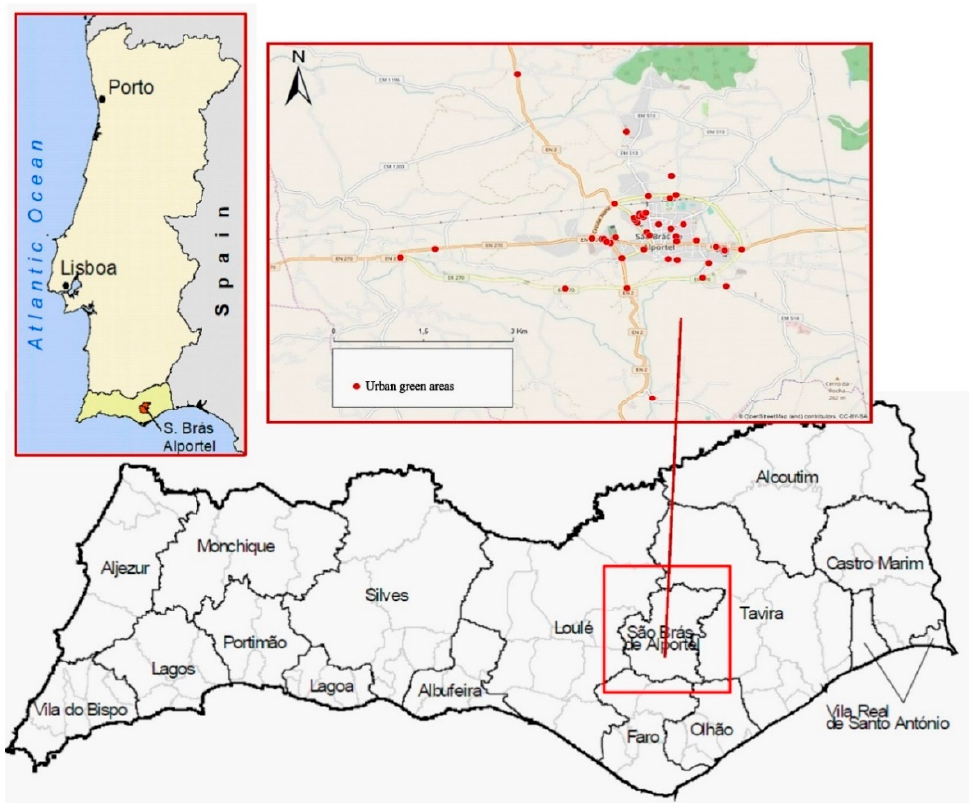
Figure 1. Localization of São Brás de Alportel, Portugal.